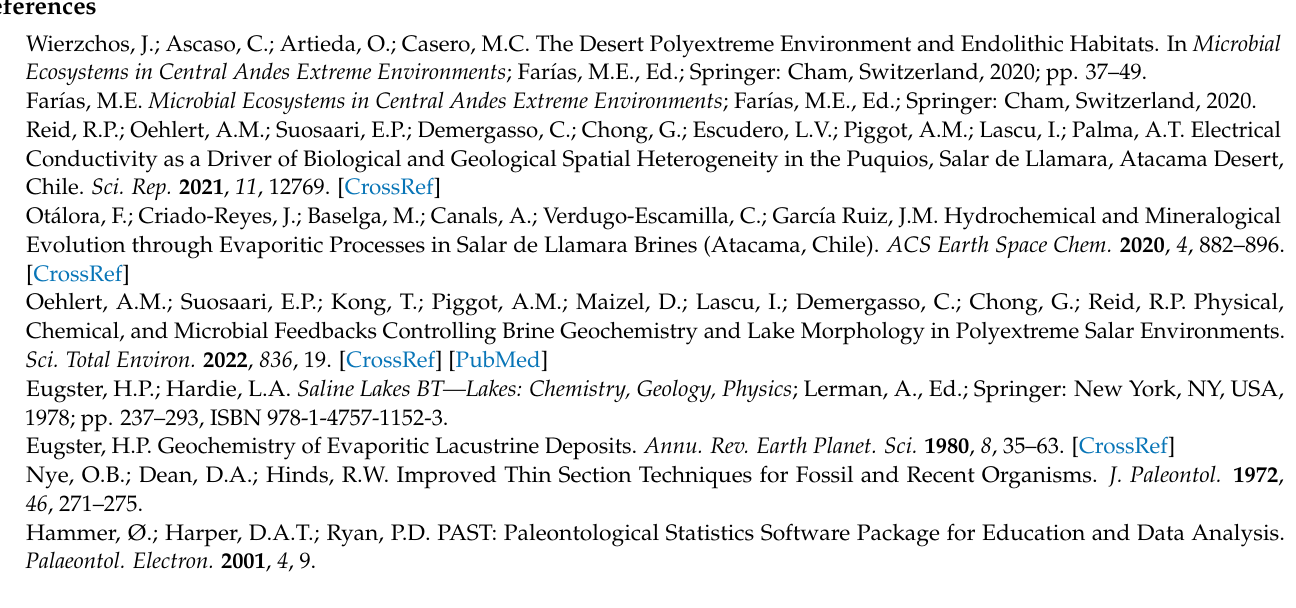
Table S1: Summary Table of Hanna parameters by bottom type; Table S2: ANOVA Post Hoc tests; Table S3: Homogenous